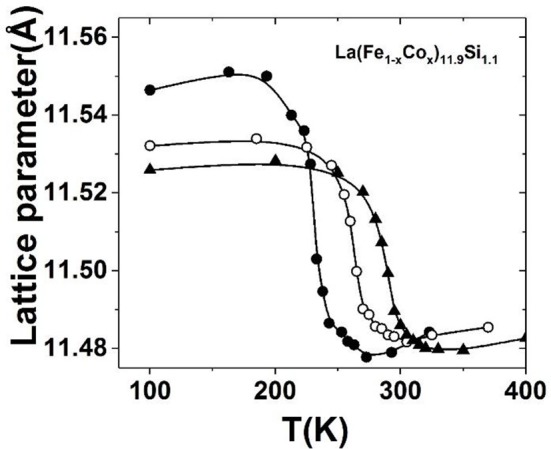
The temperature dependence of lattice parameter for La(Fe1−xCox)11.9Si1.1 (x = 0.04, 0.06, 0.08) compounds. Reprinted with permission from Hu et al. (2005).